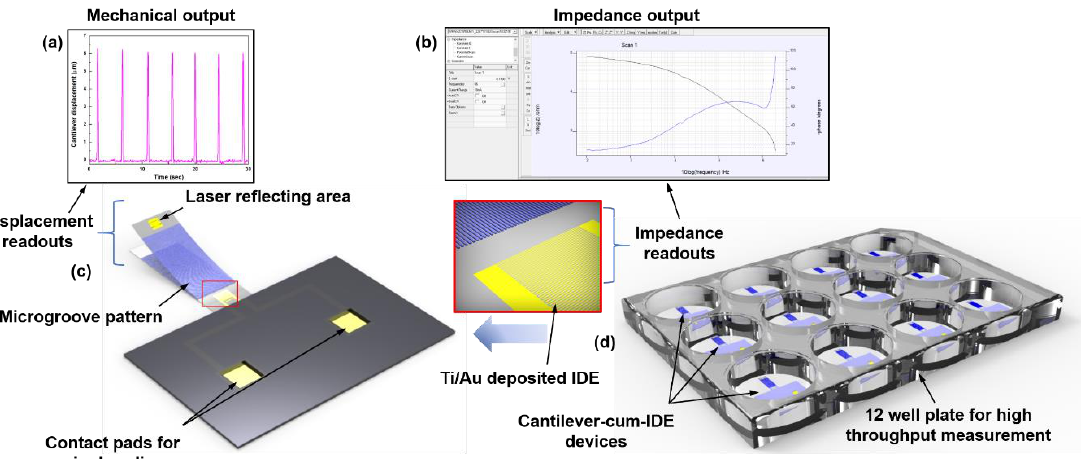
Figure 1. Schematic of the device and its working principle. ( a ) Cantilever displacement measured by the laser vibrometer with the help of laser reflecting area at the end of the cantilever. Output can be viewed in LabVIEW (version 9.0), ( b ) impedance spectrum measured from interdigitated electrode array (IDE) with the help of IviumStat software, ( c ) schematic of the cantilever device denoting positions of IDEs on the cantilever, microgrooves, laser reflecting area and contact pads for wire bonding, ( d ) schematic of the cantilever devices in a 12 well culture plate for high throughput measurement. ECIS is an e ff ective tool to monitor growth and cytotoxicity of cardiomyocytes. To monitor